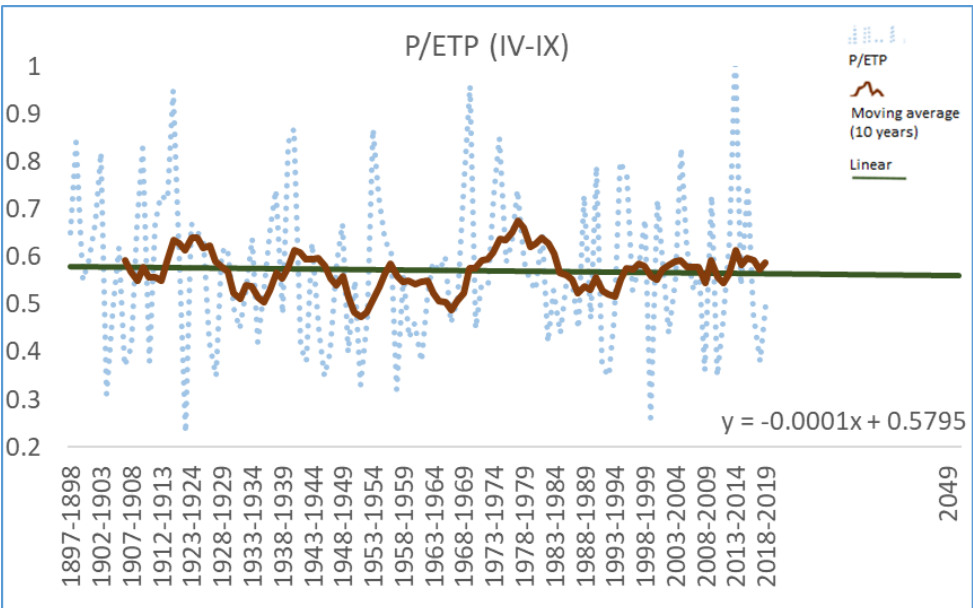
Figure 18. The evolution of the ratio of the values of the accumulated precipitations in the warm period of the year, between April (IV) and September (IX), with the evapotranspiration, registered annually in Timișoara, Romania, P /ETP (IV-IX), 1898-2019.